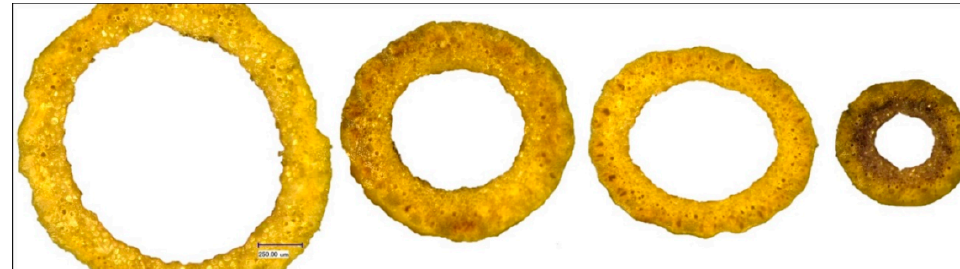
Figure 4. Diameter of selected HEB-25 lines and Barke as reference. From left to right: HEB_03_142, Barke, HEB_24_188, HEB_08_016.